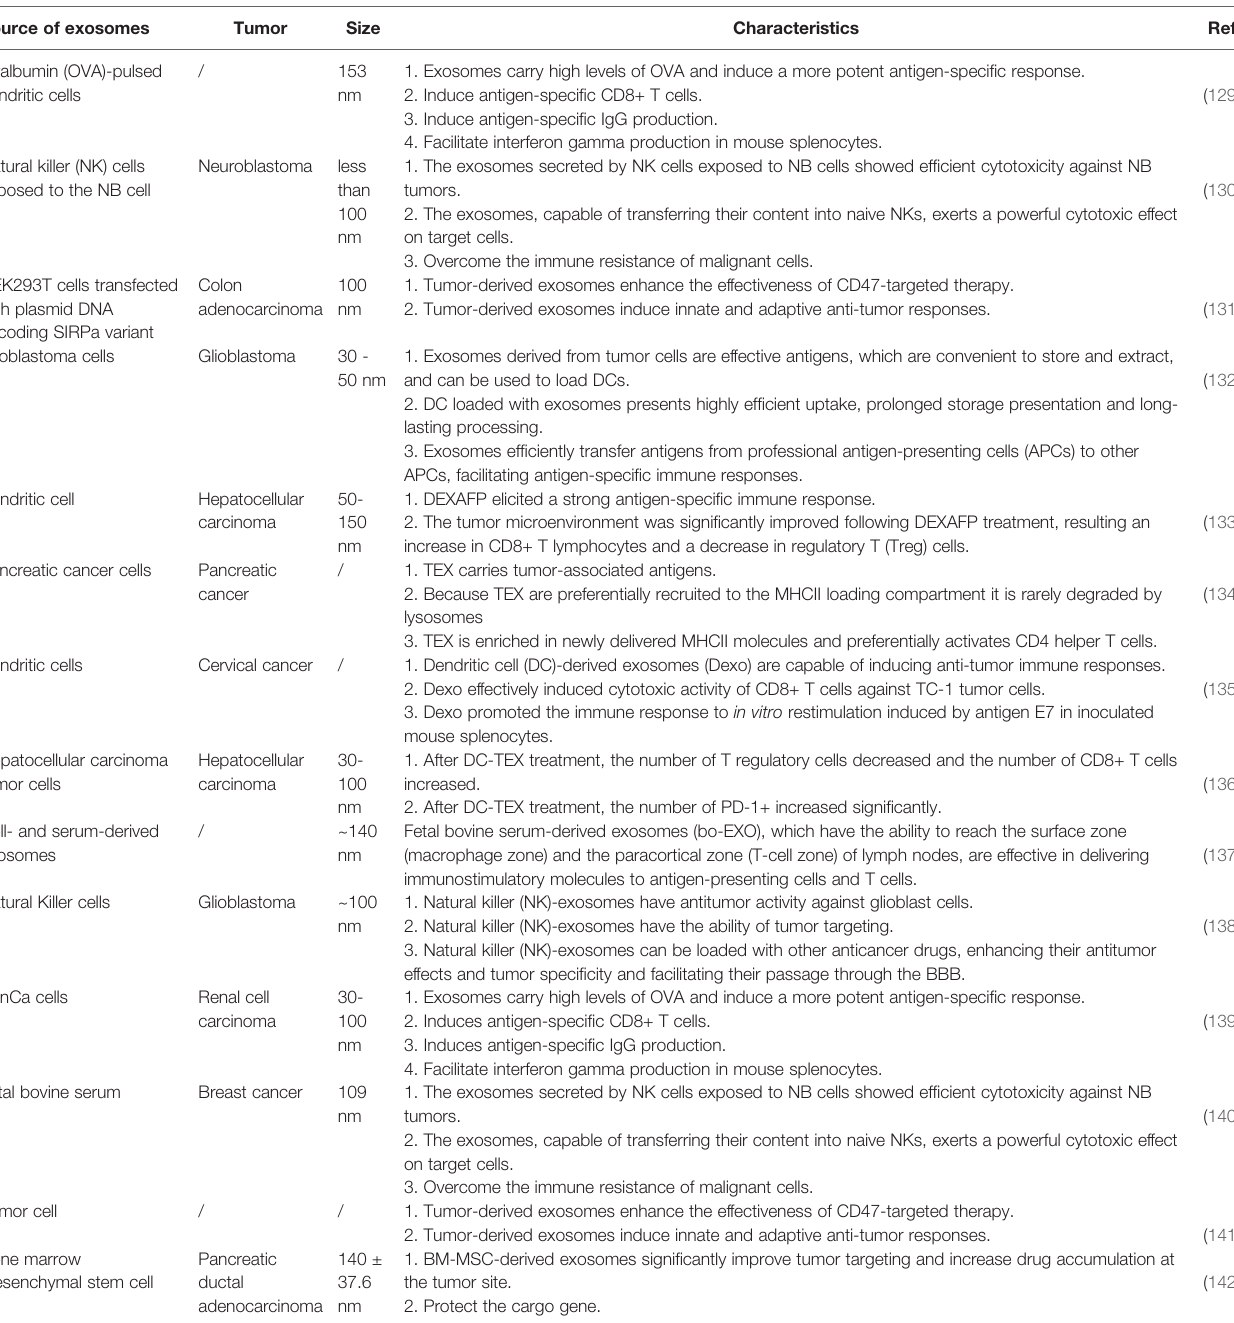
TABLE 4 | Exosome-assisted